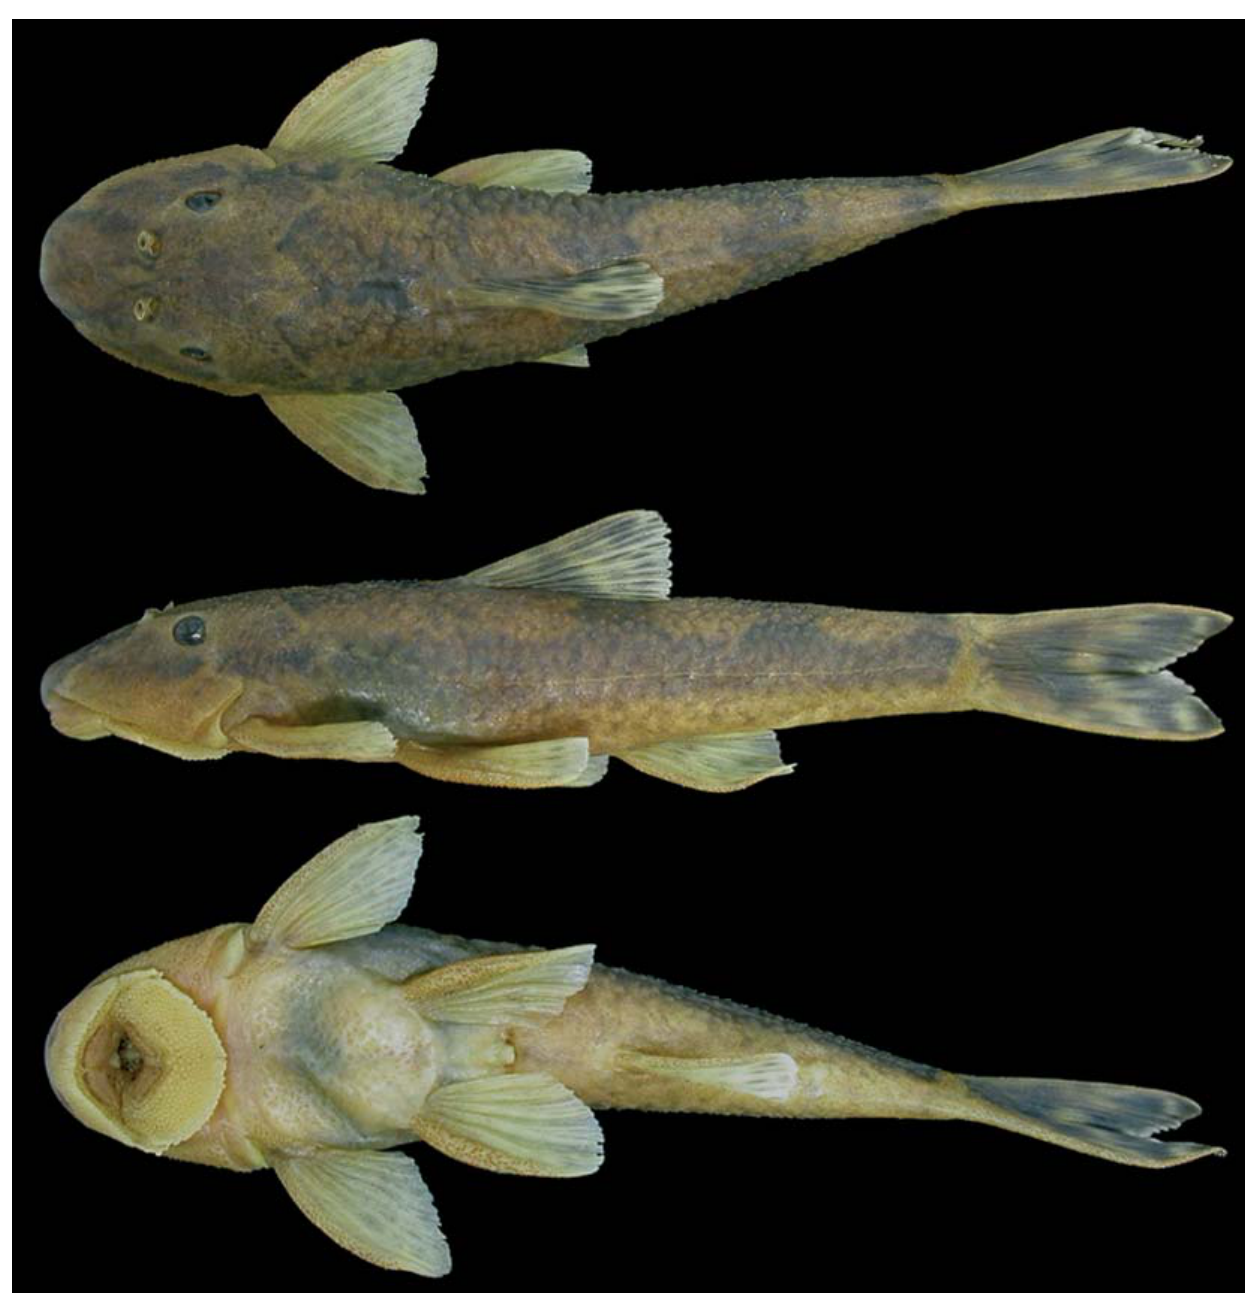
Fig. 1. Gymnotocinclus anosteos , holotype, MCN 18624, male, 44.3 mm SL, ribeirão das Cobras, near highway GO-327, tributary of rio Tocantinzinho, rio Tocantins Basin, Alto Paraíso de Goiás, Goiás,